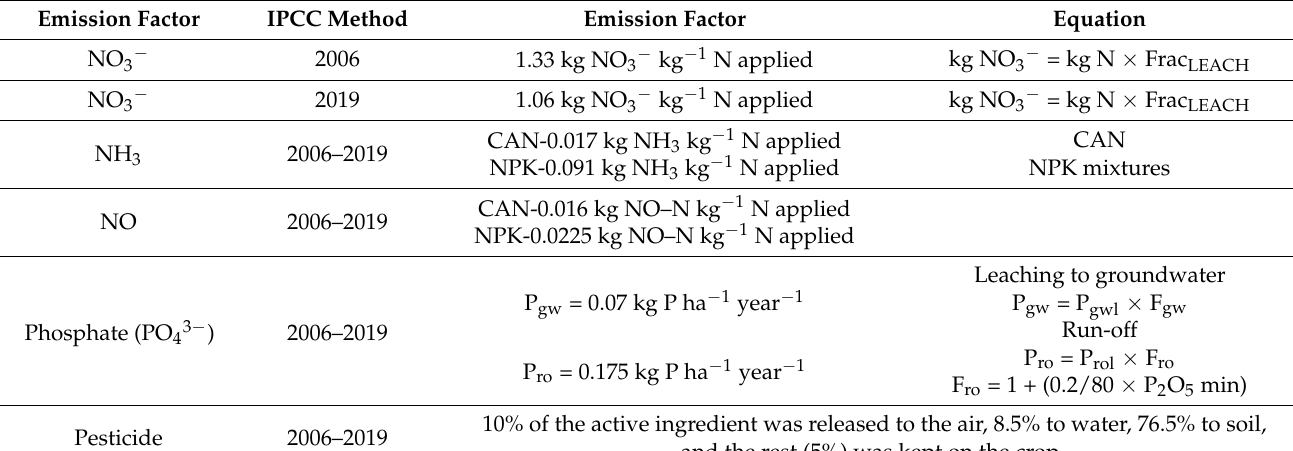
Table 3. Emission factors used for the LCA of barley